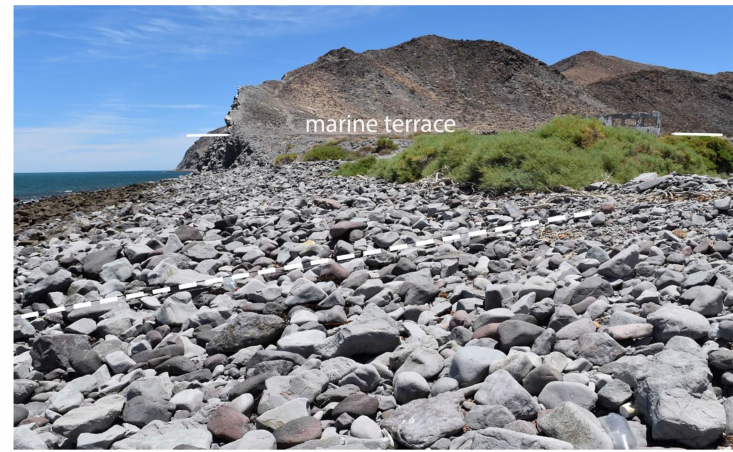
Figure 5. Transect 1 (dashed line) features the highest concentration of small and intermediate size boulders. The survey line passes through the spit about 40 m beyond the marine terrace at the NE corner of Isla San Luis Gonzaga. Superposition of white arrows defines the outer lip of the marine terrace elevated 8.5 m above sea level.